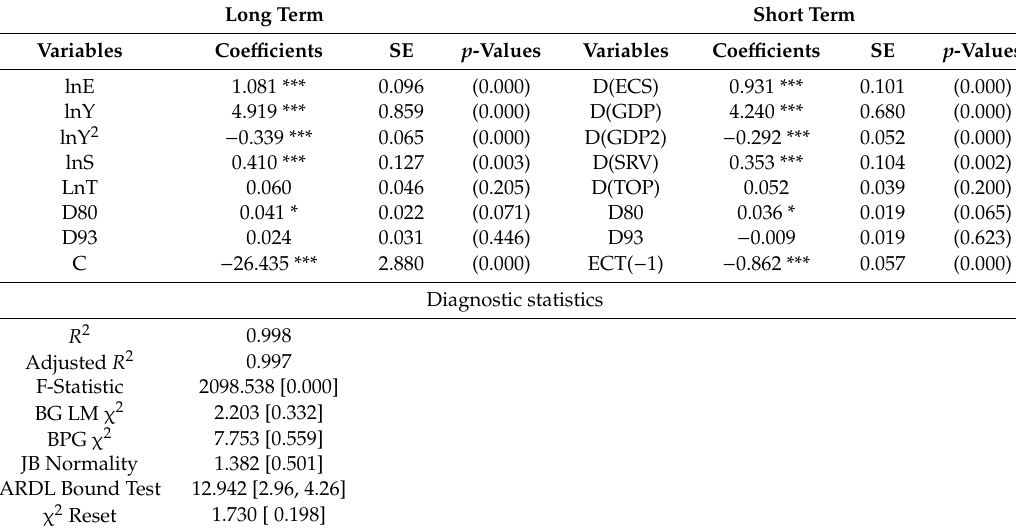
Table A2. Short-term and long-term results of ARDL model (structural analysis for years 1980 and